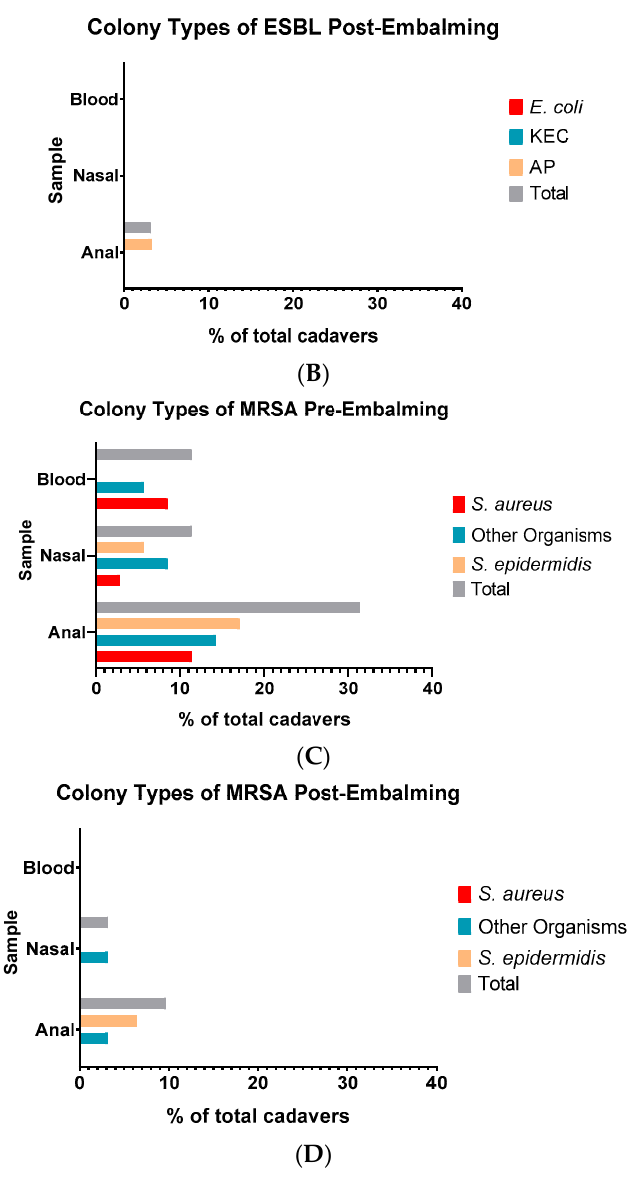
Figure 3. Differentiation of antibiotic-resistant strains. Percentages were determined based on n = 35 pre-embalming ( A , C ) and n = 31 for post-embalming ( B , D ). The total number is the number of cadavers with growth on the plates. Some sites had growth with different coloured colonies on a single plate. For ESBL plates ( A , B ), E. coli are the pink/red/purple colonies, KEC (Klebsiella, Enterobacter, and Citrobacter) are the green/purple colonies. AP (Acinetobacter and Pseudomonas) are the cream/translucent colonies. For MRSA plates ( C , D ), S. aureus is the pink/red/purple colonies (MRSA), the other organisms are the green/blue colonies, and S. epidermidis is the cream/translucent colonies (MRO).